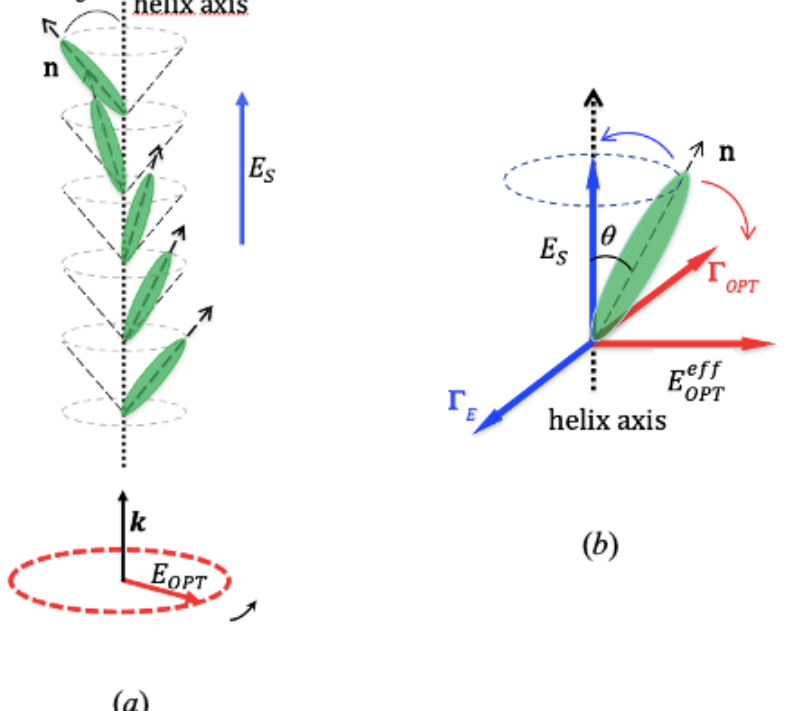
Figure 1. The analyzed geometrical configuration. ( a ) The optical field E OPT propagates with wavevector k along the direction of the helix axis of the heliconical structure being circularly polarized in the transversal plane; the static field E S is applied along the direction of the helix axis. ( b ) The competition of the optical torque Γ OPT and the static field torque Γ E acting on the molecular director toward the opposite direction. E ef f represents the component of the optical field effective at a given time.